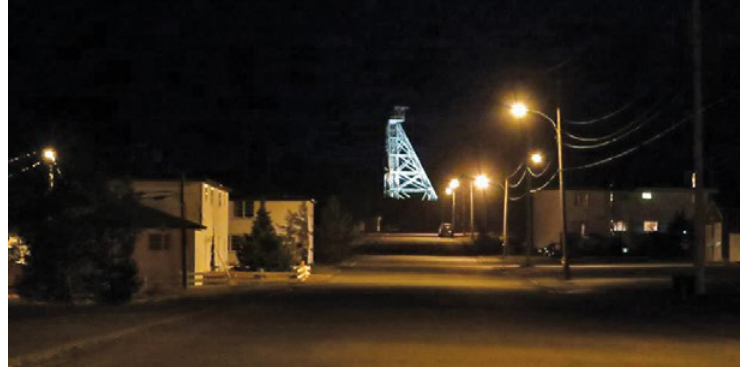
Figure 2. Lucky Strike headframe (deckhead) illuminated atop Main Street. Photo courtesy of Pauline